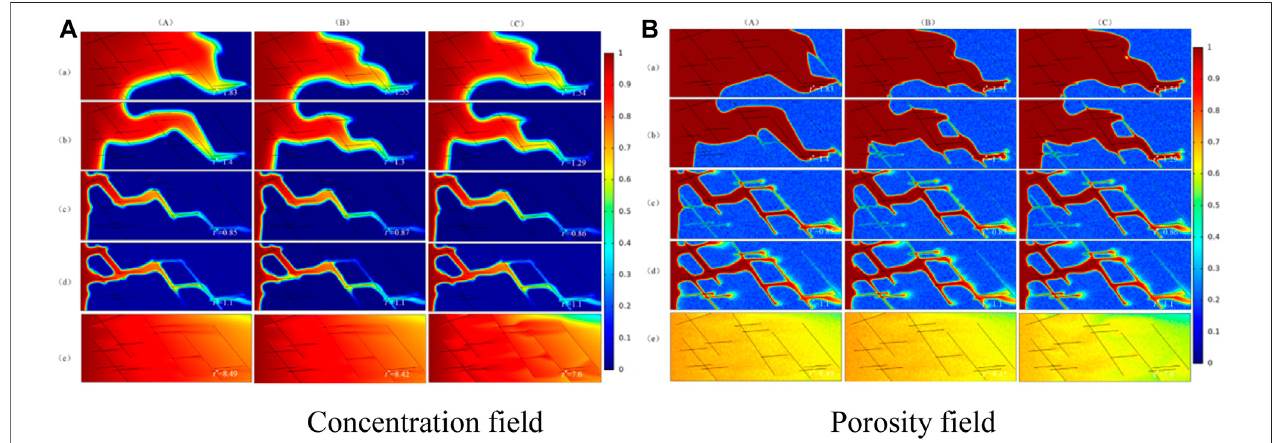
FIGURE 9 | Dissolution patterns of homogeneity of initial fracture aperture, heterogeneity of initial fracture aperture, and dynamic change of fracture aperture in fracturedmedium.(a)Facedissolution, Da (cid:1) 2000;(b)Concialdissolution, Da (cid:1) 1,000;(c)Wormhole, Da (cid:1) 250;(d)Branch dissolution, Da (cid:1) 100;(e)Uniformdissolution, Da (cid:1) 1. (A) The initial phase; (B) The dissolution structure when injected acid breaks through core.